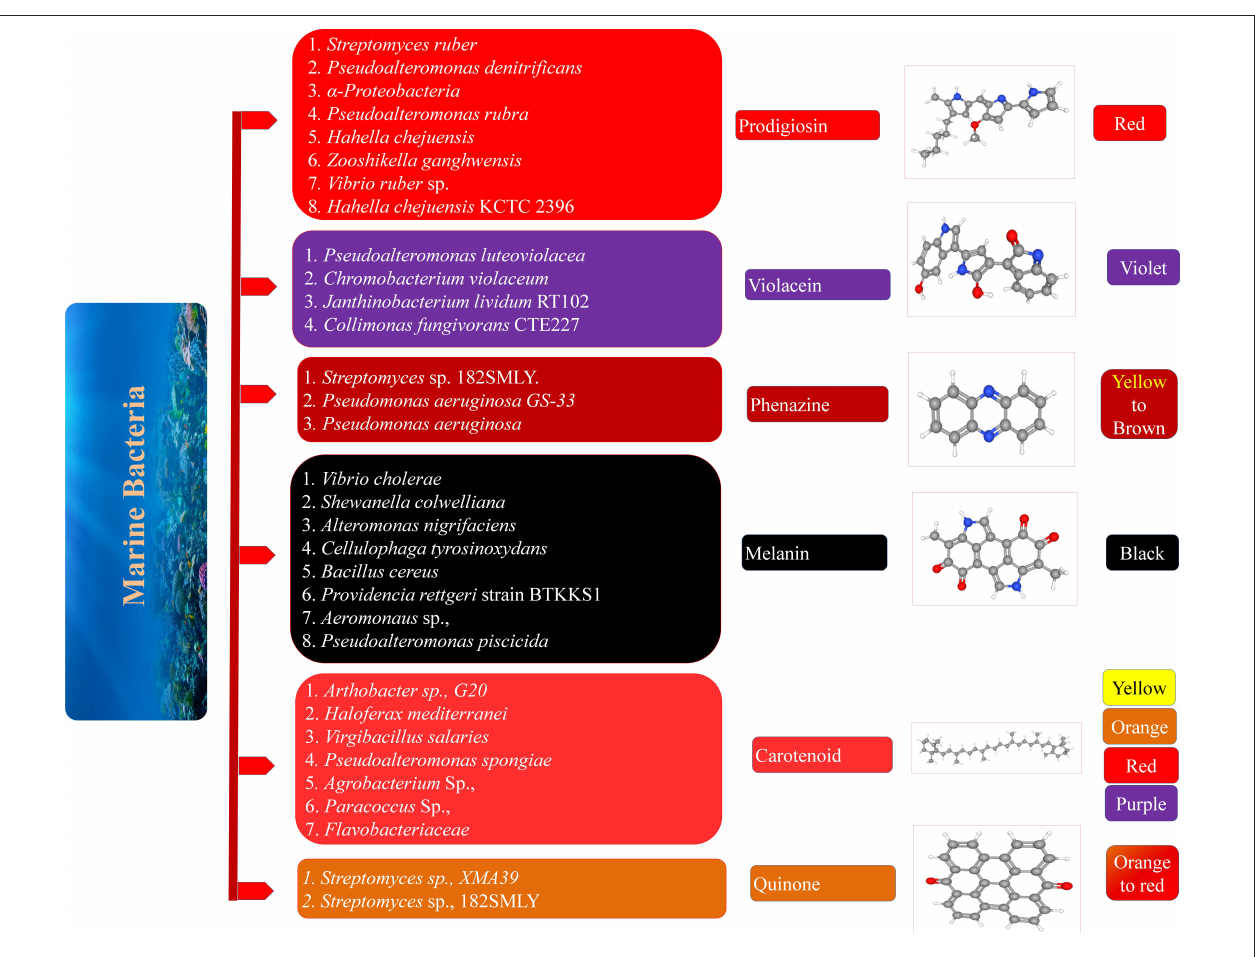
FIGURE 1 | Types of marine bacterial